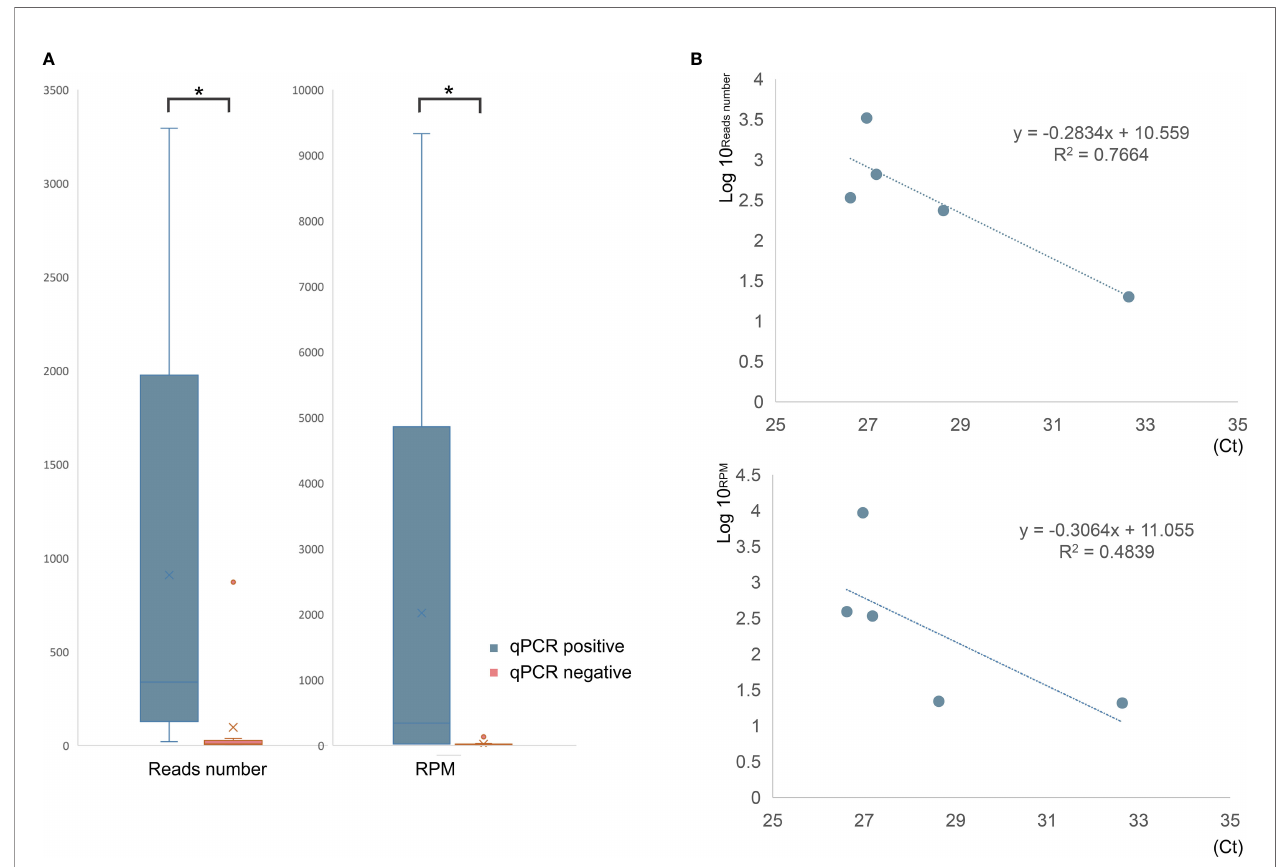
FIGURE 2 | The comparison of mNGS results between qPCR-positive and -negative samples. (A) The read number and RPM of C. psittaci were signi fi cantly higher in qPCR-positive samples than that of negative samples. (B) The relationship between reads number (top) or RPM (bottom) and cycle threshold (Ct) value of qPCR. *p < 0.05.